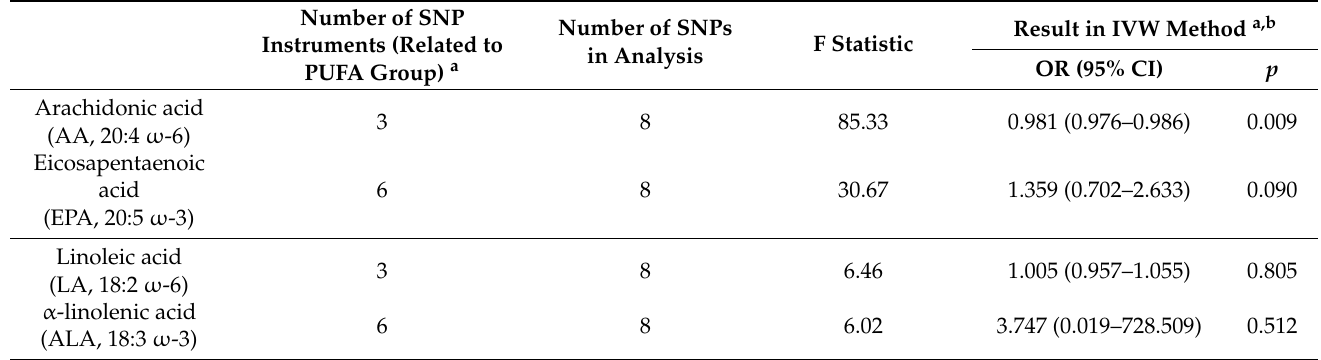
Table 4. The multivariable MR analyses for ω -6 and ω -3 PUFAs with risk for